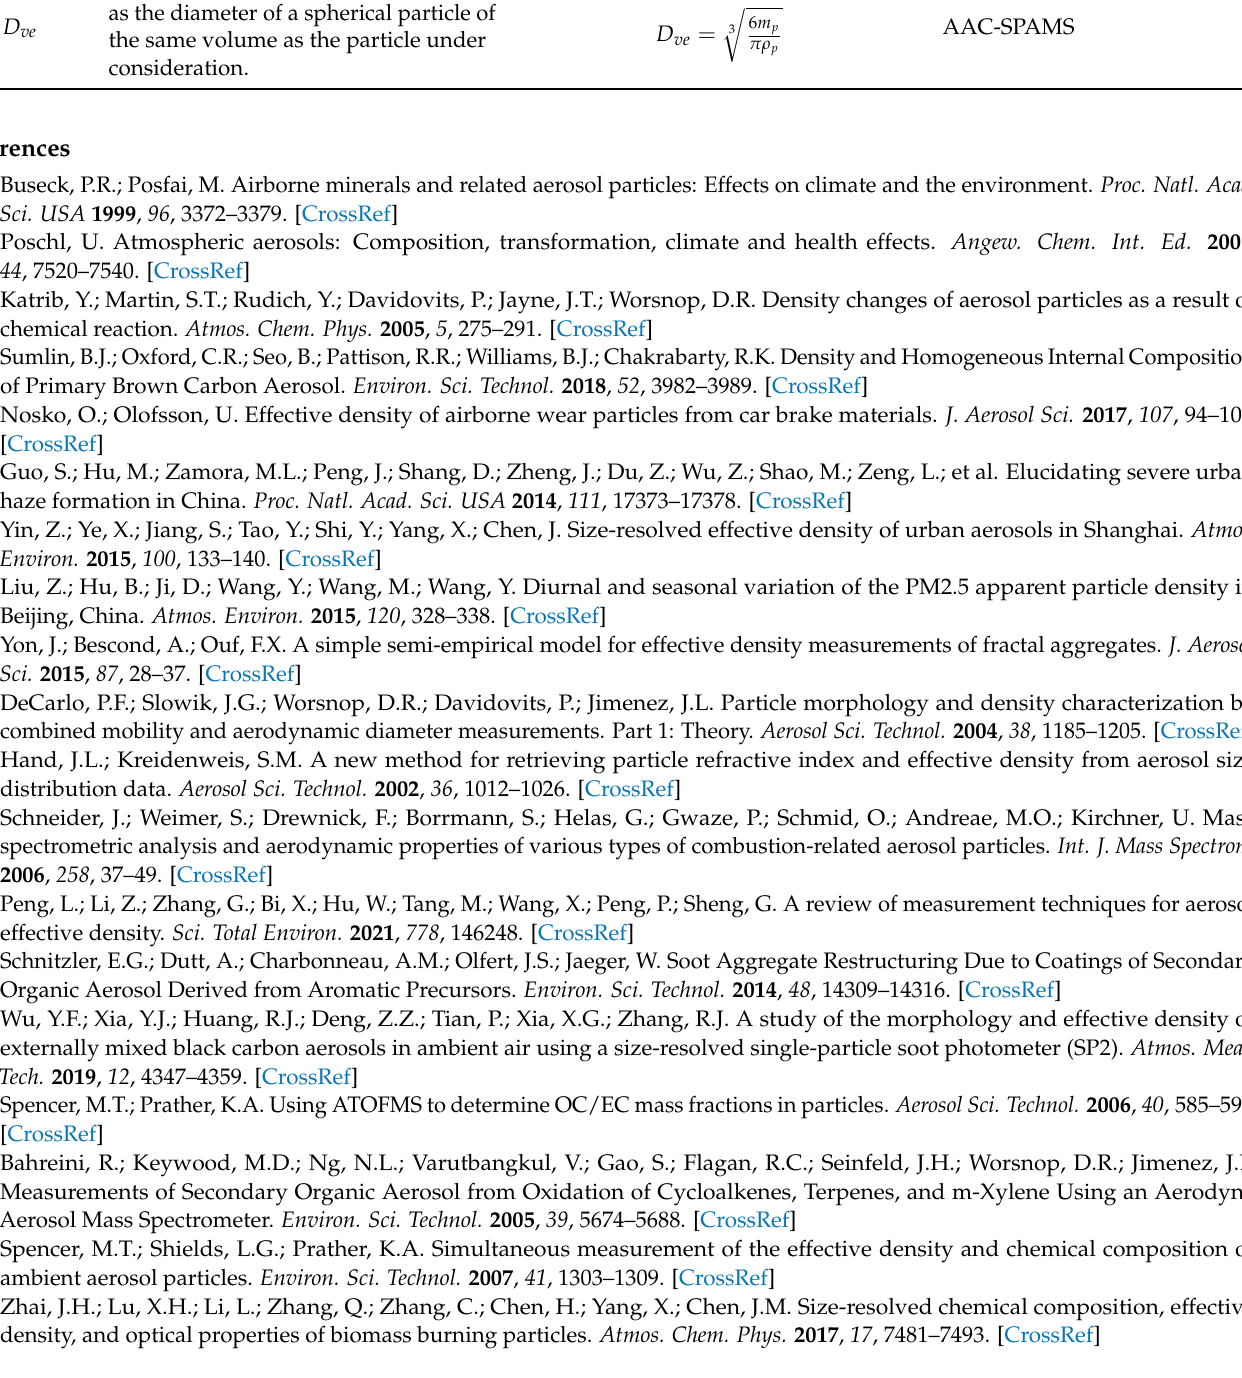
Table A1. Cont. In the free-molecular regime, the D va aerodynamic diameter is called the vacuum aerodynamic diameter. Mobility diameter is defined as the diameter of a sphere with the same D m migration velocity in a constant electric field as the particle of interest. Volume-equivalent diameter is defined as the diameter of a spherical particle of D ve the same volume as the particle under